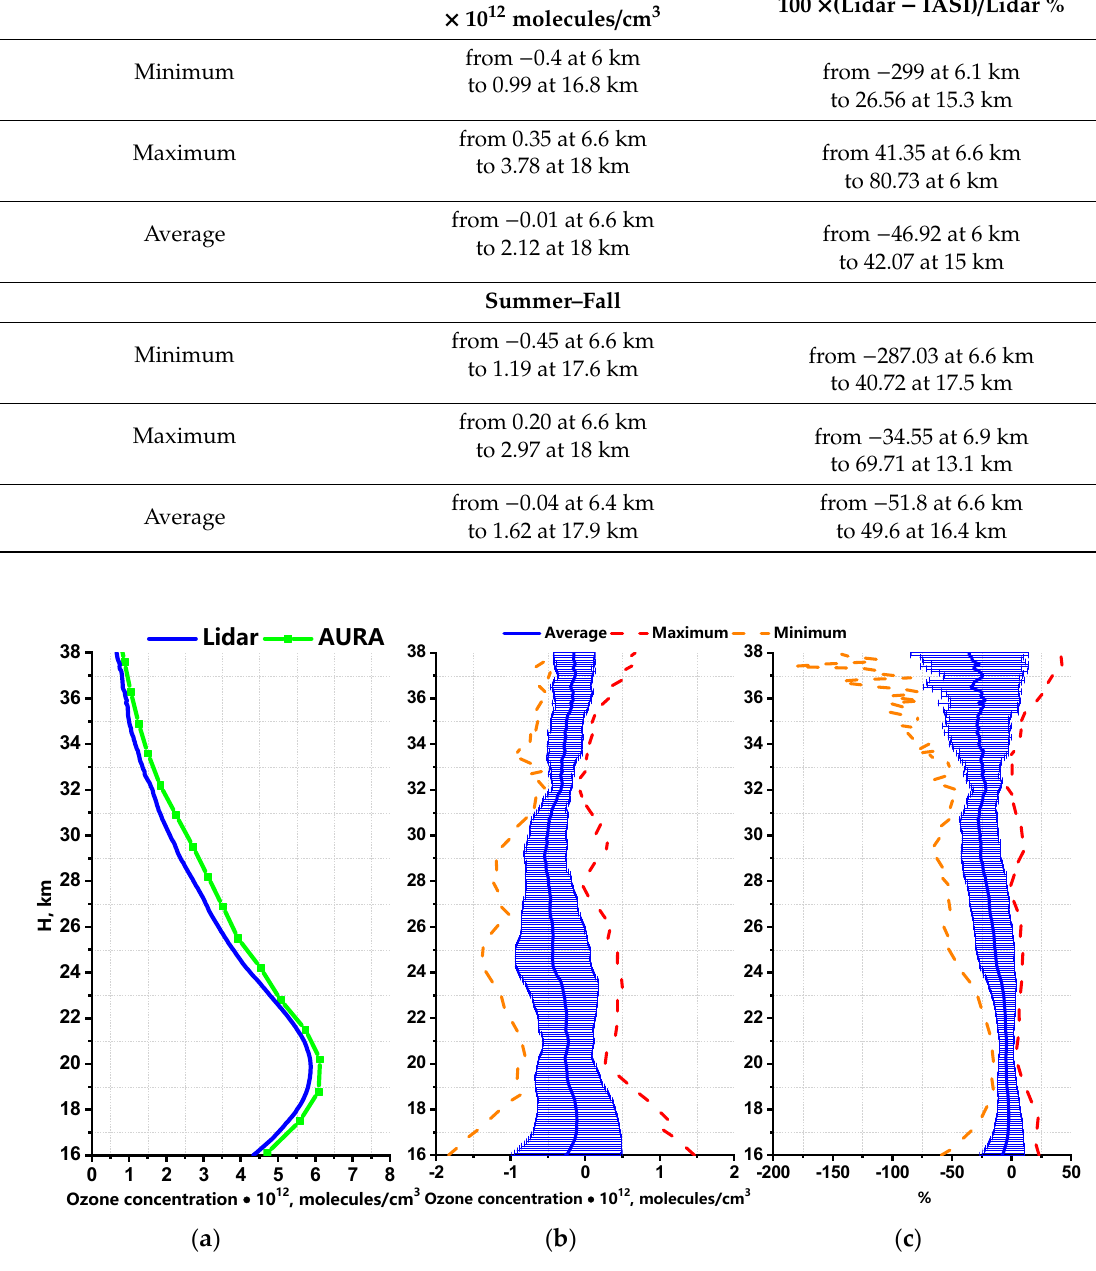
Figure 6. Average OVDs for season of winter–spring and their differences: ( a ) average profiles; ( b ) differences between the lidar and Aura data, in absolute units; and ( c ) relative differences 100 × (lidar − Aura )/lidar.